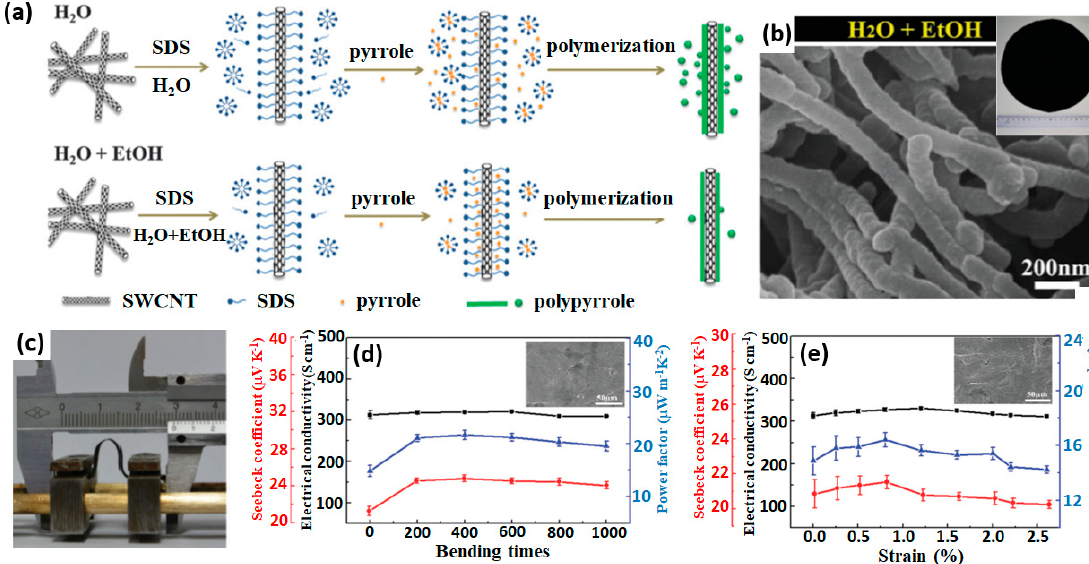
Figure 11. (a) Schematic illustration showing the preparation procedure for the PPy/SWCNT nanocomposites via a template-directed in situ polymerization approach with water or aqueous ethanol as reaction medium. (b) SEM image of the composites with a SWCNT: Py ratio of 20 wt%, prepared in the medium of aqueous ethanol. Inset is a photo of the PPy/SWCNT nanocomposite thermoelectric film. (c) Bending measurement of the flexible film with a bending radius of 2 mm. (d) thermoelectric performance of the PPy/SWCNT nanocomposite film (40 wt%, aqueous ethanol) before and after bending up to 1000 times. (e) Dependence of mechanical stretching on the thermoelectric performance of the PPy/SWCNT nanocomposite film (40 wt%, aqueous ethanol). Insets are SEM images showing no cracks after bending or stretching. Readapted with permission from The Royal Society of Chemistry [96].